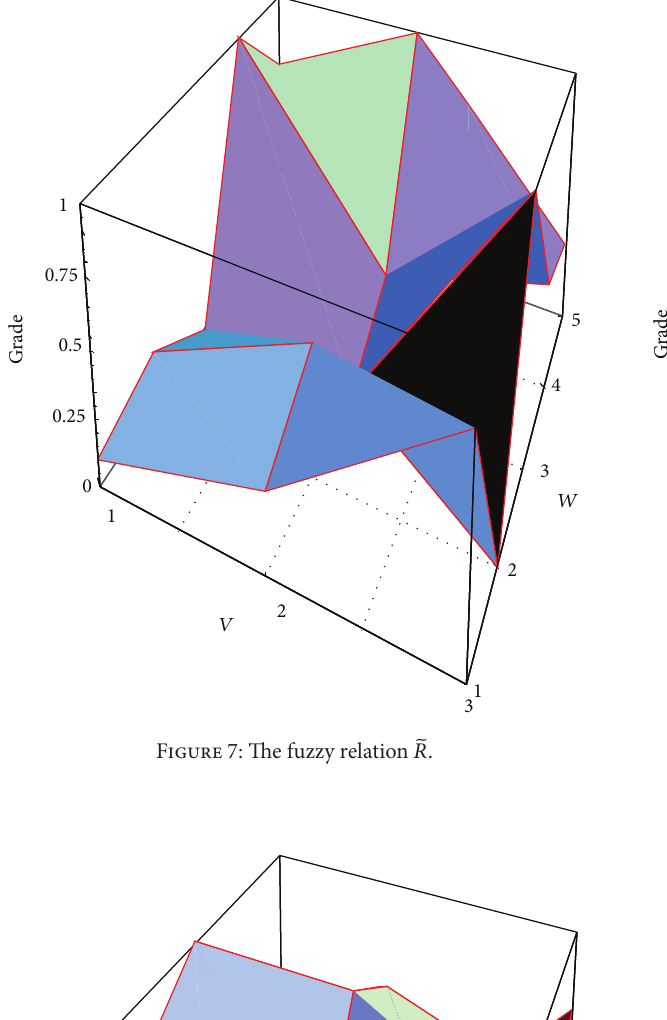
Figure 7: The fuzzy relation